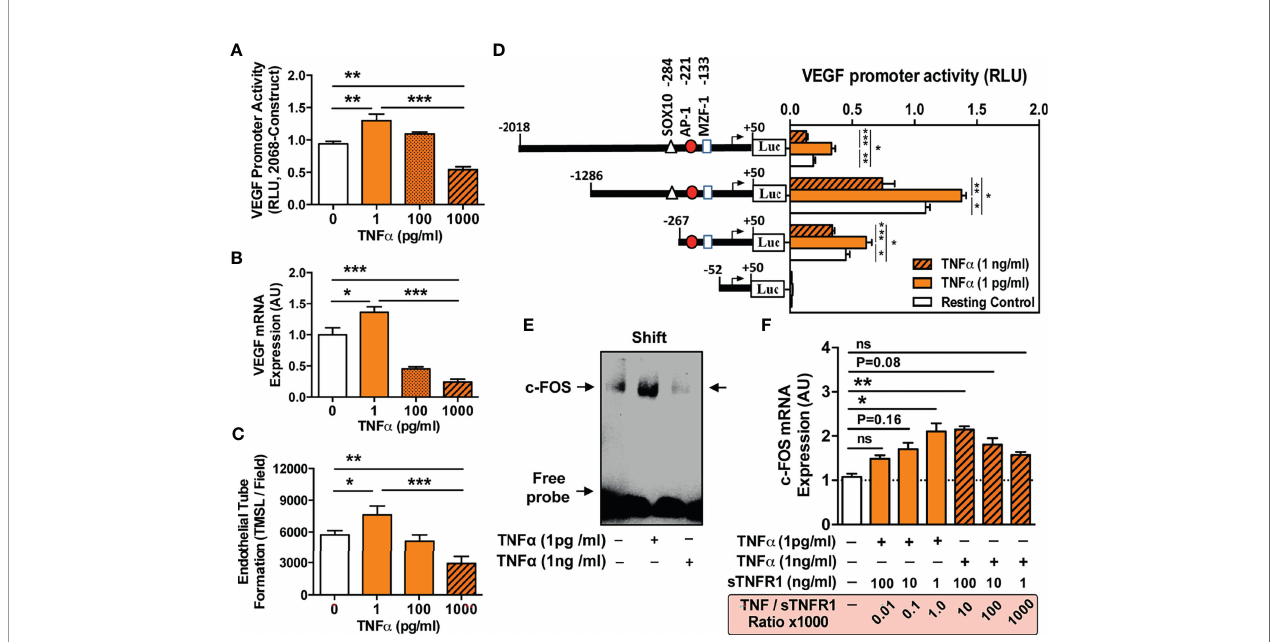
FIGURE 5 | TNF- a concentration-dependent VEGF promoter activation and angiogenesis and VEGF promoter sequences responsive to TNF- a stimulation. (A – C) ECs were stimulated with different concentrations of TNF- a (1 to 1000 pg/ml) to assess: (A) VEGF promoter activation (RLU; relative luciferase activity, 3-hour stimulation with TNF- a , n=4) in cells transfected with the pLuc 2068 full-length luciferase-reporter construct; and (B) VEGF mRNA expression (AU; arbitrary units, 3- hour stimulation with TNF- a , n=4); and (C) Endothelial tube formation (TMSL/ fi eld; total master segment length per fi eld averaged of 5 assessed fi elds per condition, 16-hour stimulation with TNF- a , n=12). (D) To identify VEGF promoter sequences responsive to TNF- a stimulation ECs were transfected with different VEGF promoter constructs subjected to progressive 5 ’ -deletions (full-length -2018 construct and -1286, -267, and -52 deletion) and the relative luciferase activity (RLU, n=4) determined in cells stimulated for 6 hours with TNF- a (1 pg/mL or 1000 pg/ml) compared to unstimulated resting control cells, demonstrating a loss in VEGF promoter activity upon truncation of the promoter region spanning the positions -267 to -52, and simultaneous identi fi cation of a potential high af fi nity AP-1/c-FOS binding site at position -102 with computation analysis. (E) Validation of the AP-1/c-FOS transcription factor-binding site with EMSA (one representative experiment shown) using biotin-labeled double-stranded oligonucleotides targeting to the calculated AP-1/c-FOS positions at -95 to -119 of the corresponding VEGF promoter region. ECs were stimulated for 6 h with TNF-a (1 pg/mL or 1000 pg/ml) and nuclear fractions analyzed for formation of nuclear complexes with the c-FOS probe (labeled as a shift with arrow); and (F) Effect of sTNF-R1 (1, 10, and 100 ng/ml) on the modulation of TNF- a induced c-FOS mRNA-expression (AU; 3-hour stimulation with 1 or 1000 pg/ml TNF- a , n=4) with corresponding TNF- a /sTNF-R1 ratios (0.01, 0.1, 1.0, 10, 100, 1000). 1way-ANOVA with Mean ± SEM, with * P < 0.05, ** P < 0.01, and *** P < 0.001. ns, not signi fi cant.